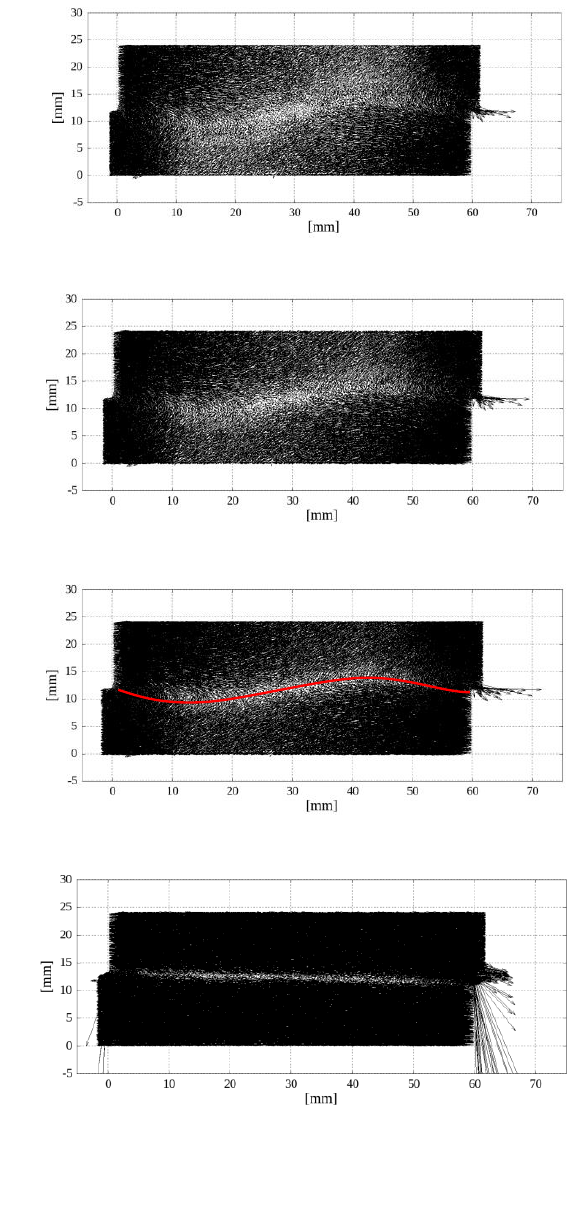
Fig.24: Evolution of displacements fluctuations ( ) in the entire specimen for: 𝑢𝑢⃗⃗ 𝑖𝑖 − 𝑢𝑢⃗⃗ 𝑎𝑎𝑎𝑎𝑎𝑎 a) u x =0.25 mm, b) u x =0.50 mm, c) u x =0.75 mm, d) u x =1.00 mm, e) u x =1.25 mm, f) u x =1.50 mm, g) u x =1.75 mm, h) u x =2.00 mm and i) u x =10.00 mm ( e 0 =0.60, σ 0 =200 kPa, d 50 =0.5 mm) (the arrows are multiple by 10 due to readability) (red lines shows the estimated localization